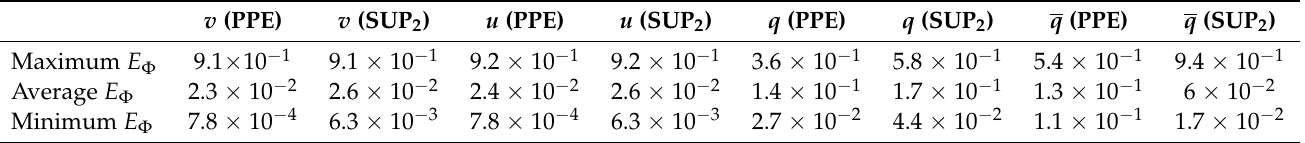
Figure 2. Time history of L 2 norm of the relative error for the velocity fields ( top ) and pressure fields ( bottom ) for NOS-ROM, PPE-ROM, SUP 1 -ROM, and SUP 2 -ROM. The legend in the top left panel is common to all the panels. We report minimum, average, and maximum relative errors for PPE and SUP 2 in Table 2. The average errors for u and q are comparable to the values obtained in [29]. Table 2. Maximum, average, and minimum relative errors for the velocity and pressure fields for PPE-ROM and SUP 2